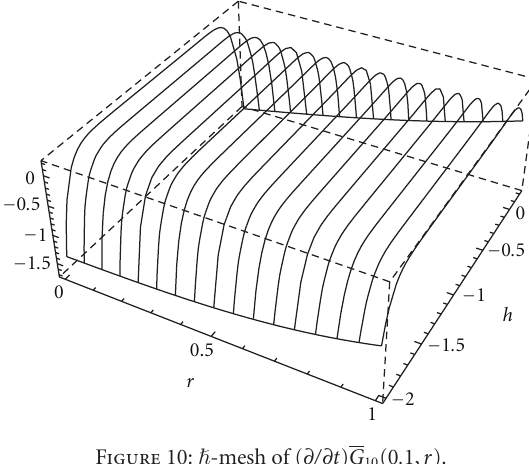
Figure 9: (cid:2) -mesh of ( ∂/∂t ) G